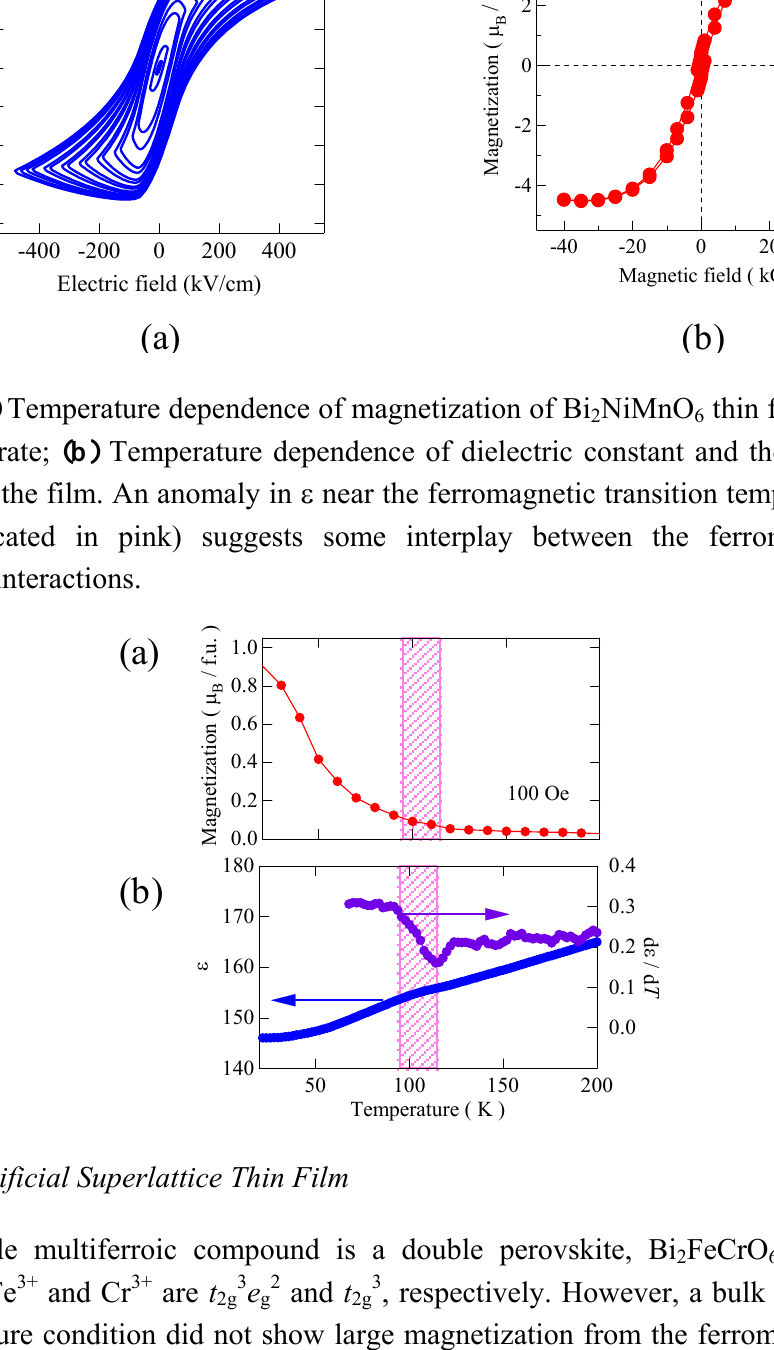
Figure 7. (a) Ferroelectric hysteresis curves of the Bi of the film. Clear polarization hysteresis loops confirm the ferroelectricity of the film; (b) Magnetization curve measured at 5 K of the thin film. A typical ferromagnetic behavior was seen.